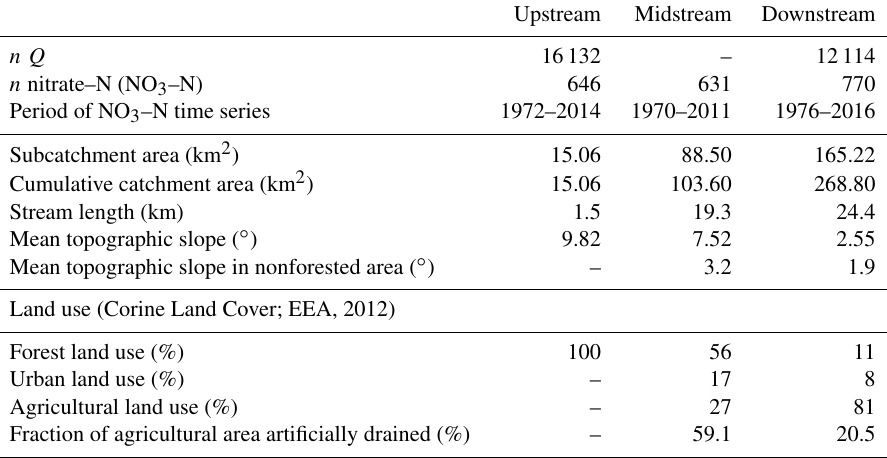
Table 1. General information on the study area, including input–output datasets; n – number of observations, Q – discharge. Upstream Midstream Downstream n Q